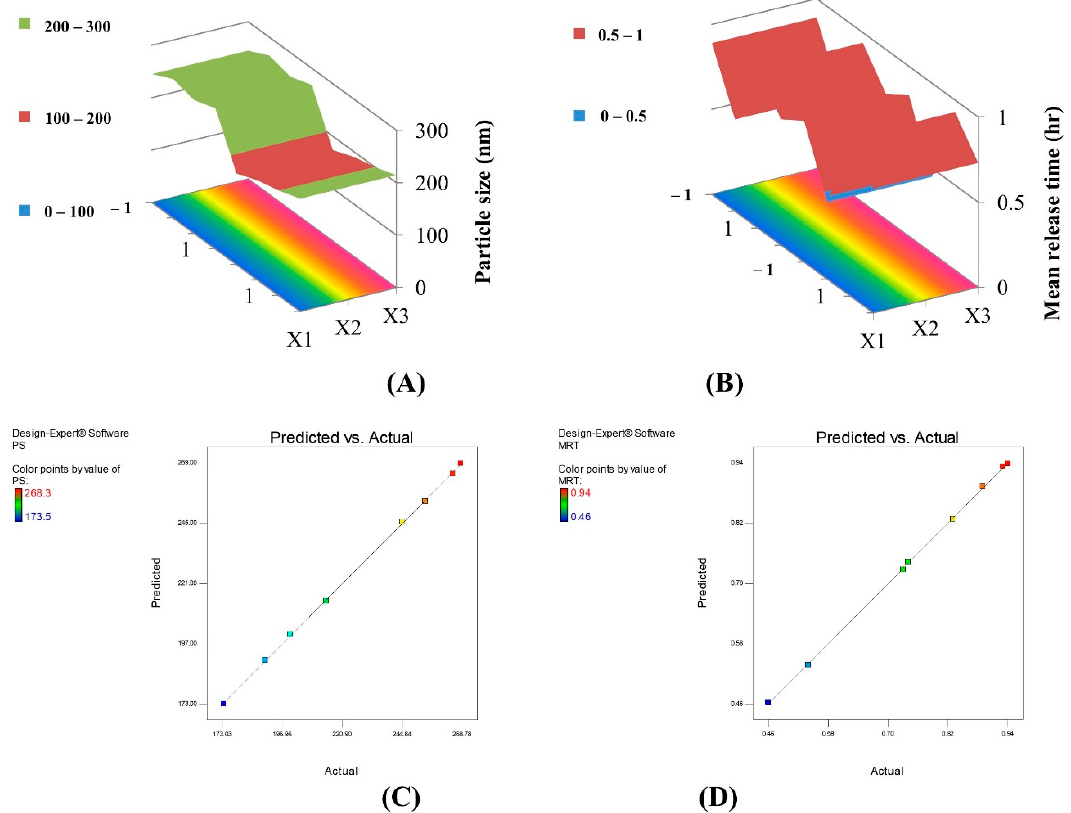
Figure 1. ( A ) The 3D surface response plot representing Y1 (PS). ( B ) The 3D surface response plot representing Y5 (MRT). ( C ) Predicted versus actual plot (PS). ( D ) Predicted versus actual plot (MRT). The combination between X2 and X3 had a synergistic Table 1. Particle size (PS), size distribution (PDI), Zeta potential (ZP), encapsulation efficiency (EE), mean release time (MRT) of the prepared HNCNs and Model summary statistics for the influence of formulations variables on the measured responses *.